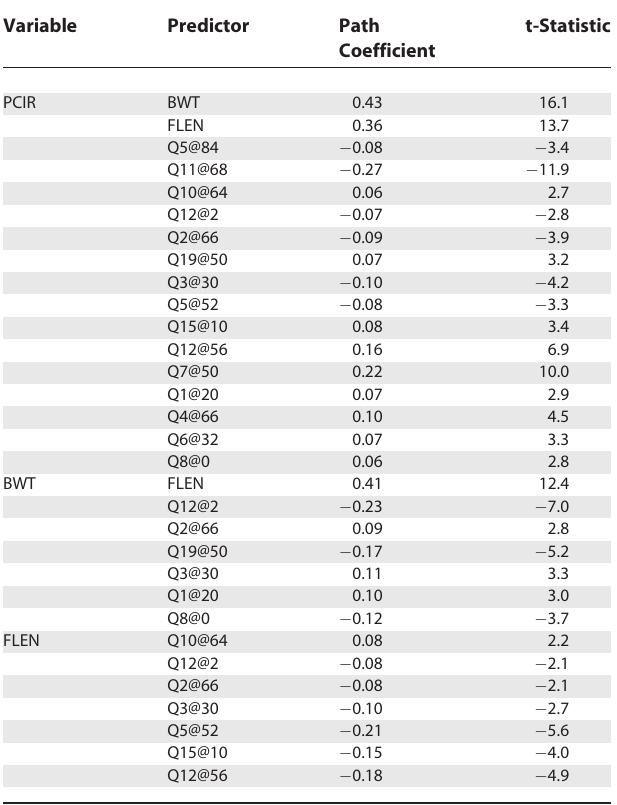
Table 5. Structural Equations for the Bone Geometry Model